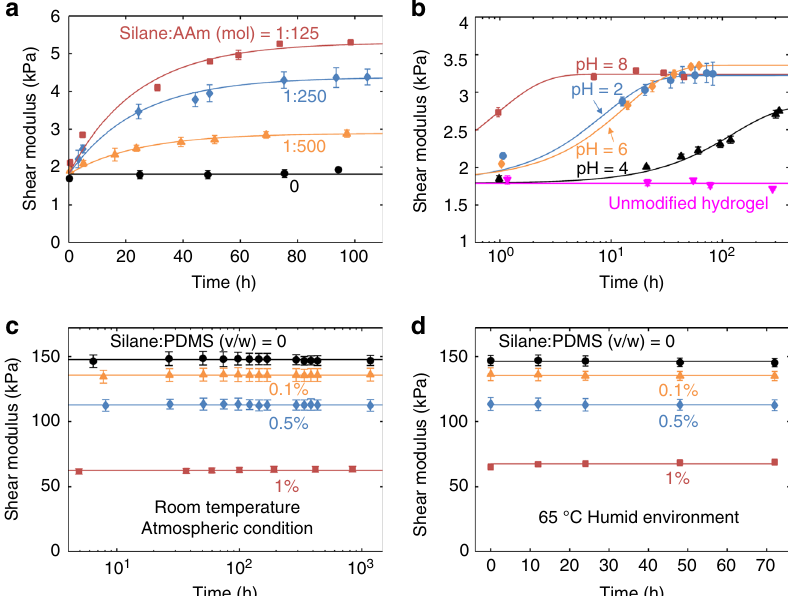
Fig. 4 The kinetics of silane coupling agents in PAAm and PDMS. a The modulus of the PAAm hydrogel changes with time as the coupling agents condensate. The amount of coupling agent does not affect the initial modulus, but affects the modulus after condensation. b The rate of condensation of trimethyloxysilane inside a hydrogel depends on pH. c The modulus of the PDMS elastomer does not change with time, but decreases as the amount of coupling agent increases. d PDMS with different amounts of TEOVS is sealed in a Petri dish with drops of distilled water and kept at 65 °C in an oven. The modulus does not change over time ( n =